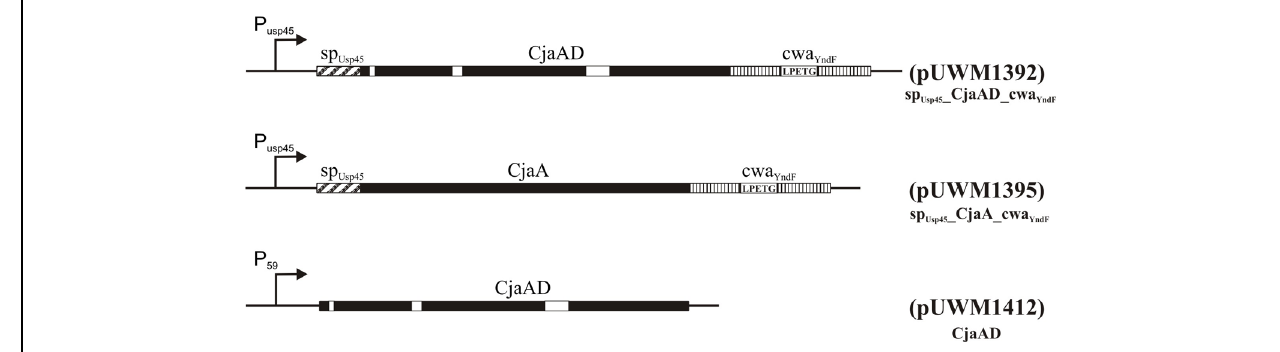
FIGURE 5 | Schematic representation of the hybrid proteins. P 59 and P Usp45 are strong, constitutive lactococcal promoters (van der Vossen et al., 1987), sp refers to the signal peptide of Usp45 (van Asseldonk et al., 1990) and cwa to the cell wall anchor region of the lactococcal protein YndF. Epitopes of CjaD proteins are marked with white rectangles. The corresponding plasmids are indicated in